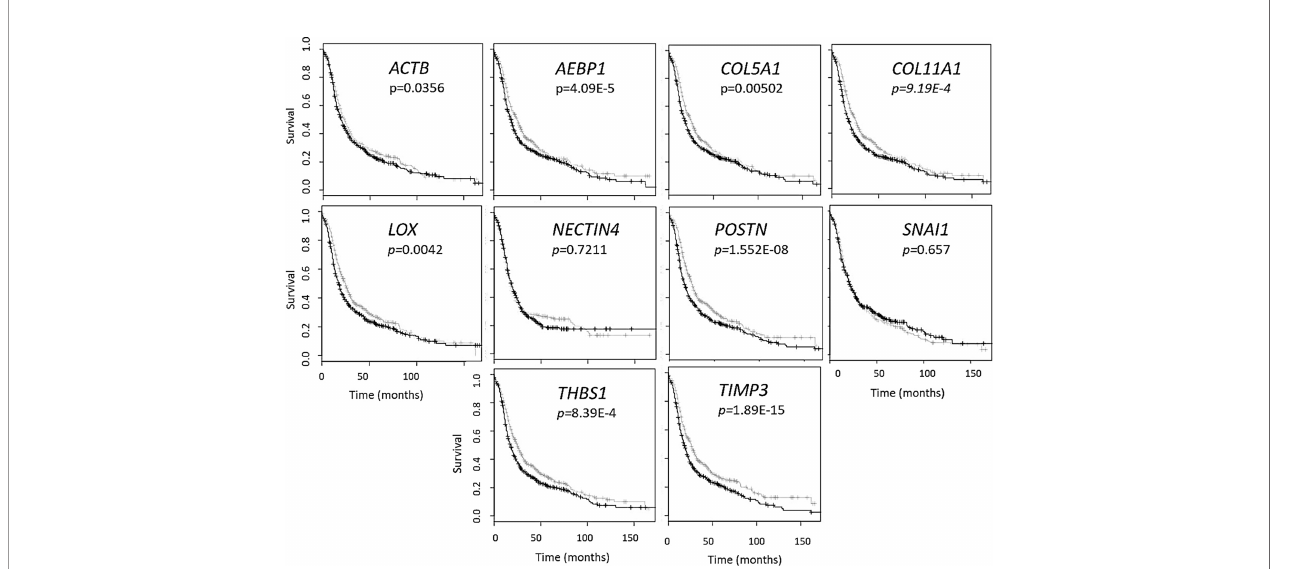
FIGURE 1 | Gene panel expression correlates with disease-free survival in ovarian cancer patients. Kaplan-Meier curves show the difference between high expression (black line) of the individual gene and low expression (grey line). The OvMark algorithm used Cox regression analysis and log-rank p values to determine the difference in expression levels. NECTIN4 and SNAI1 were the only two genes to not show a signi fi cant difference between high and low expression of the disease with regards to disease-free